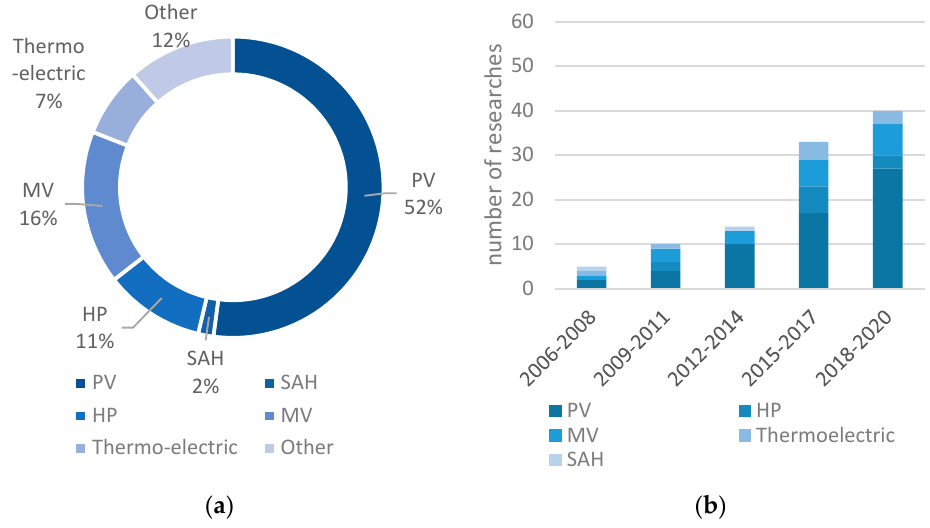
Figure 7. Active technologies included in the research papers ( a ); trend of using different active technologies over the years 2006–2020 ( b ).